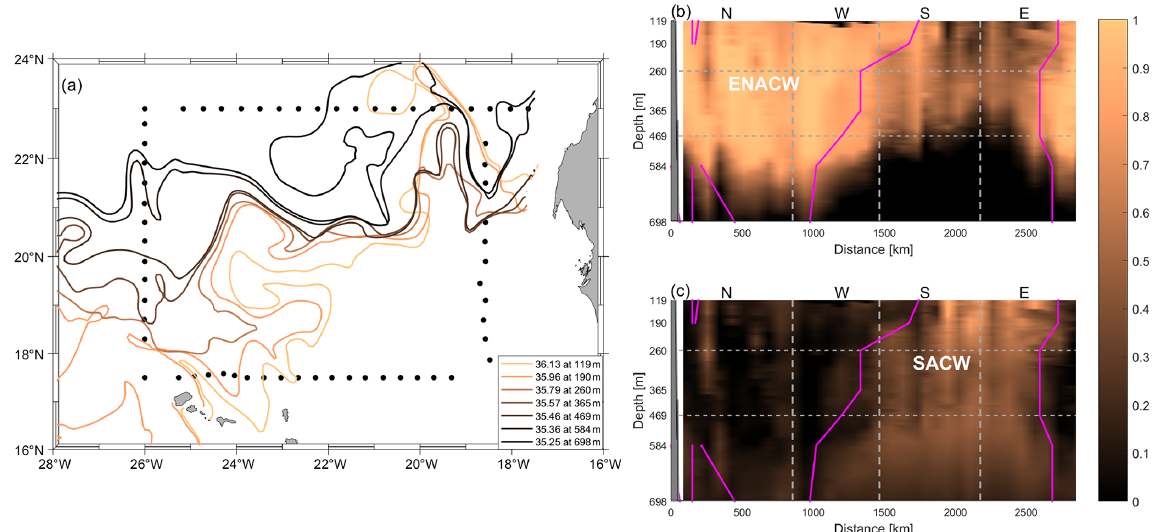
Figure 10. (a) Location of the front at the 36.07, 35.88, 35.67, 35.43, 35.31, 35.2 and 35.08 isohalines, corresponding to average depths of 119, 190, 260, 365, 469, 584 and 698m, equivalent to 26.46, 26.63, 26.85, 26.98, 27.162, 27.28 and 27.40kgm − 3 , respectively. Vertical sections of the three layers of CW with the percentages of ENACW (b) and SACW (c) , and the front location superimposed by pink lines. The direction chosen for the representation is the same as in Fig. 3. The northwestern, southwestern and southeastern corners are indicated by three vertical gray dashed lines. Three layers are also separated by two horizontal gray dashed